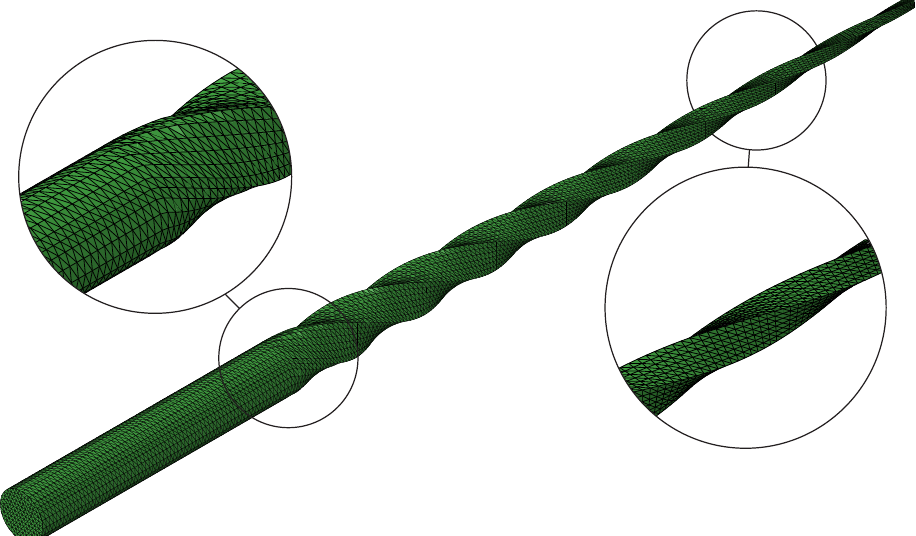
Figure 6. Finite element mesh for the endodontic file; the average element size is 0.10 mm ( n θ = 24 and n v =